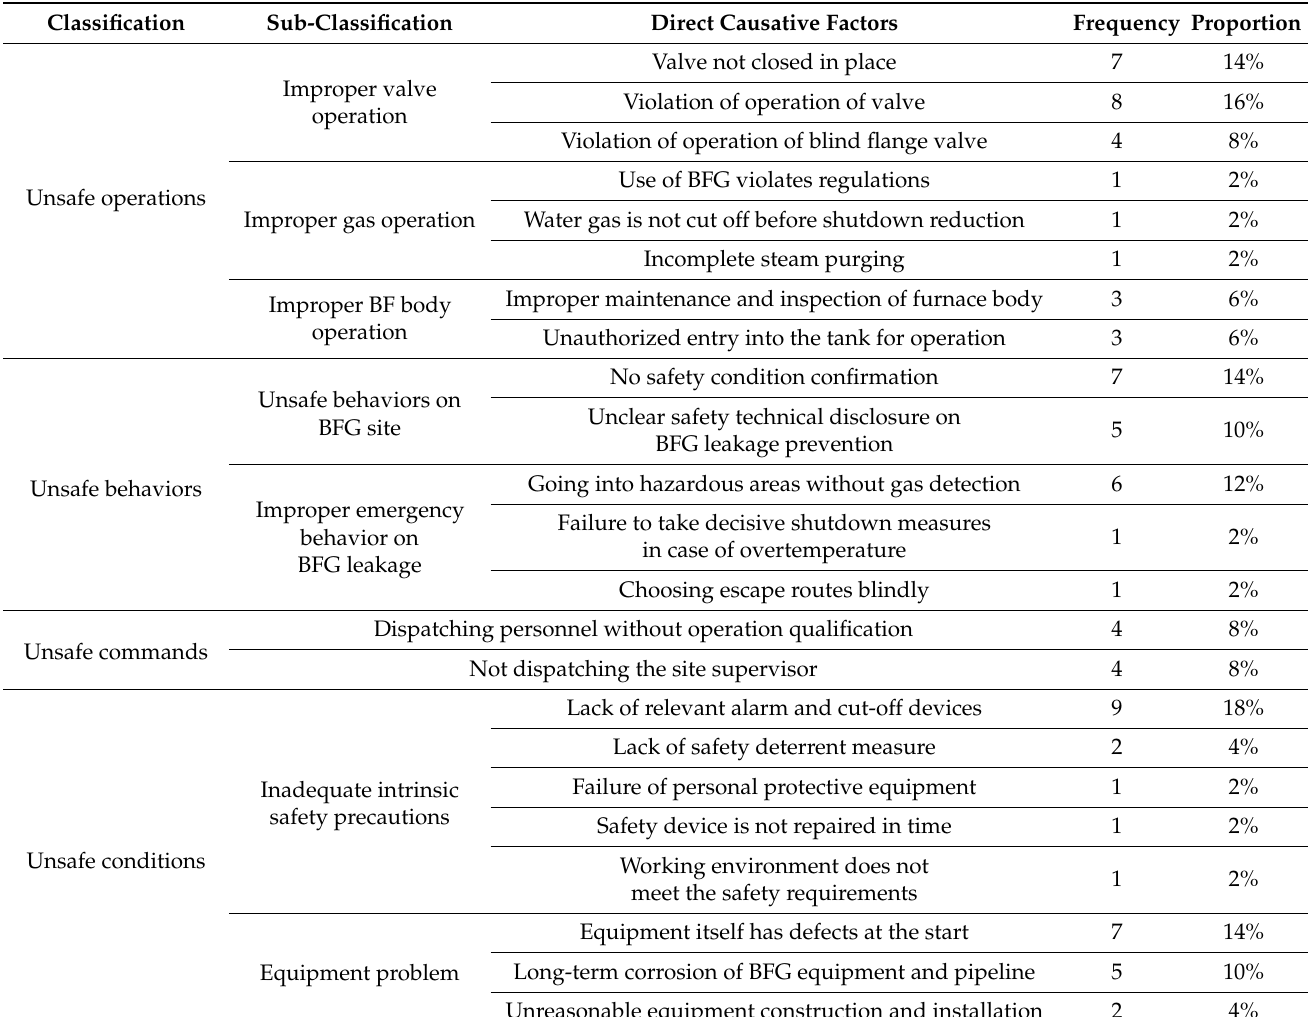
Table 1. Causative factors as immediate causes of BFG leakage